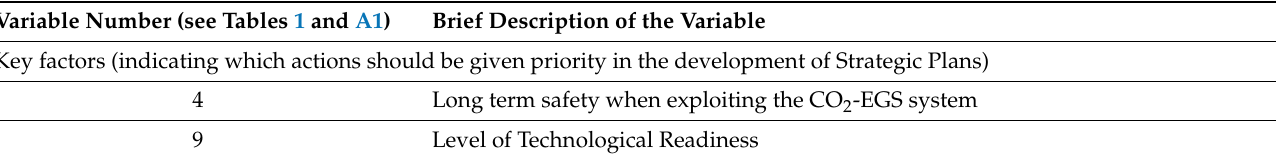
Table 2. Assignment of variables to parameter group